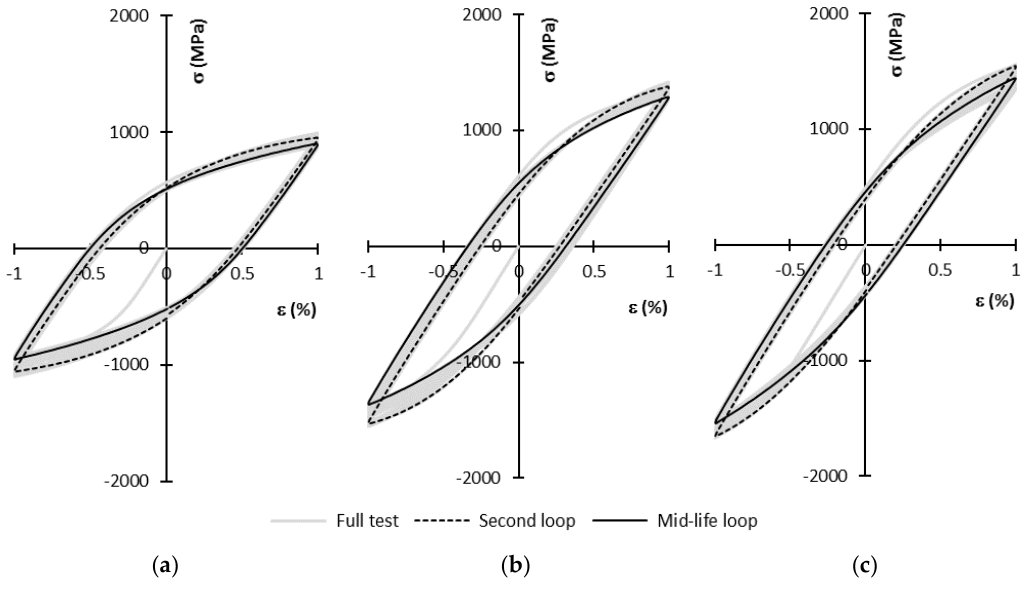
Figure 2. Cyclic stress–strain response of: ( a ) steel A; ( b ) steel B; and ( c ) steel C (Data from [9]).